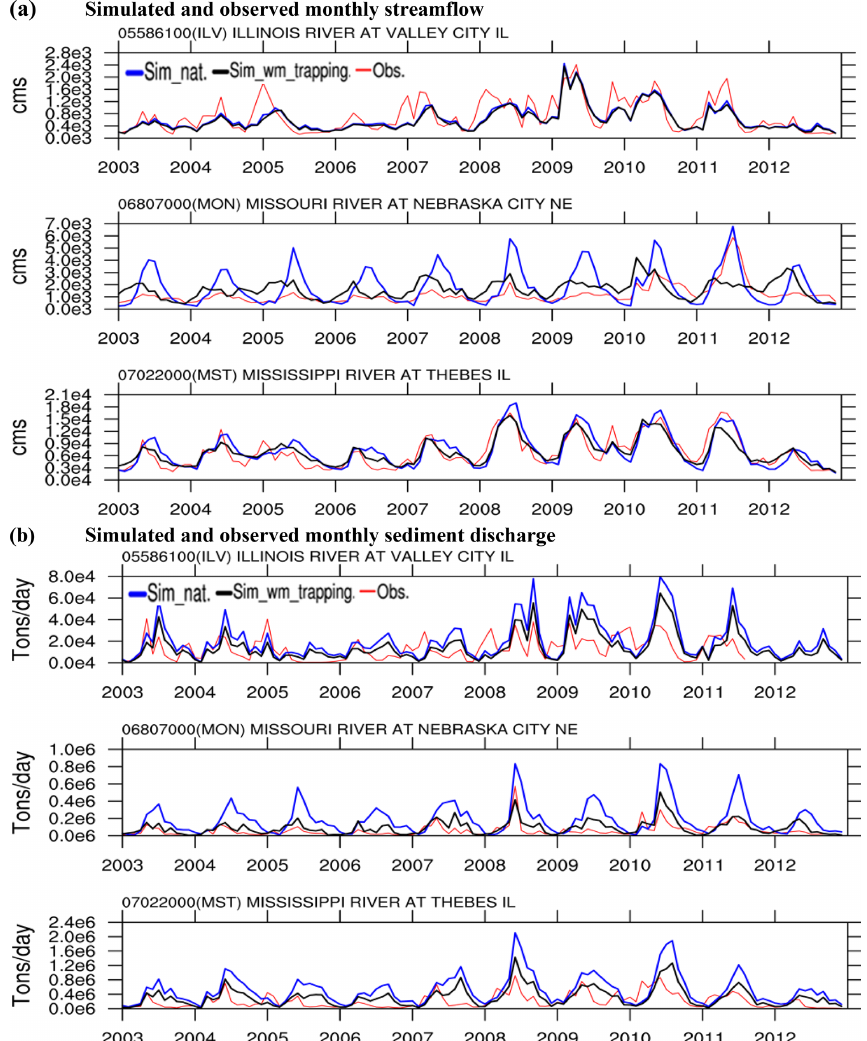
Figure 8. Simulated and observed monthly streamflow and suspended sediment discharge at three USGS gauges representative of different levels of flow regulation. For clarity, only the sim_nat and sim_wm_trapping results are displayed